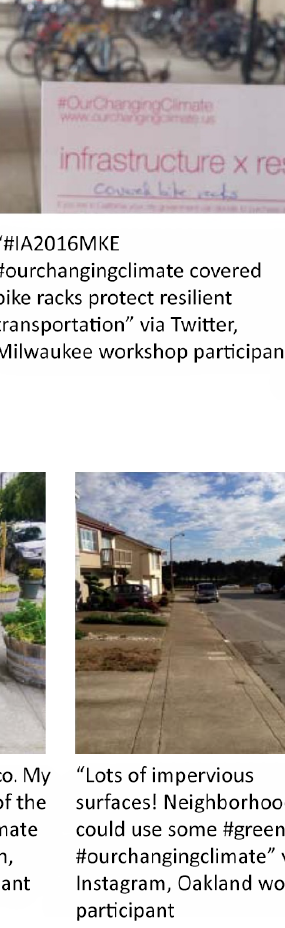
Figure 7. Green space-related